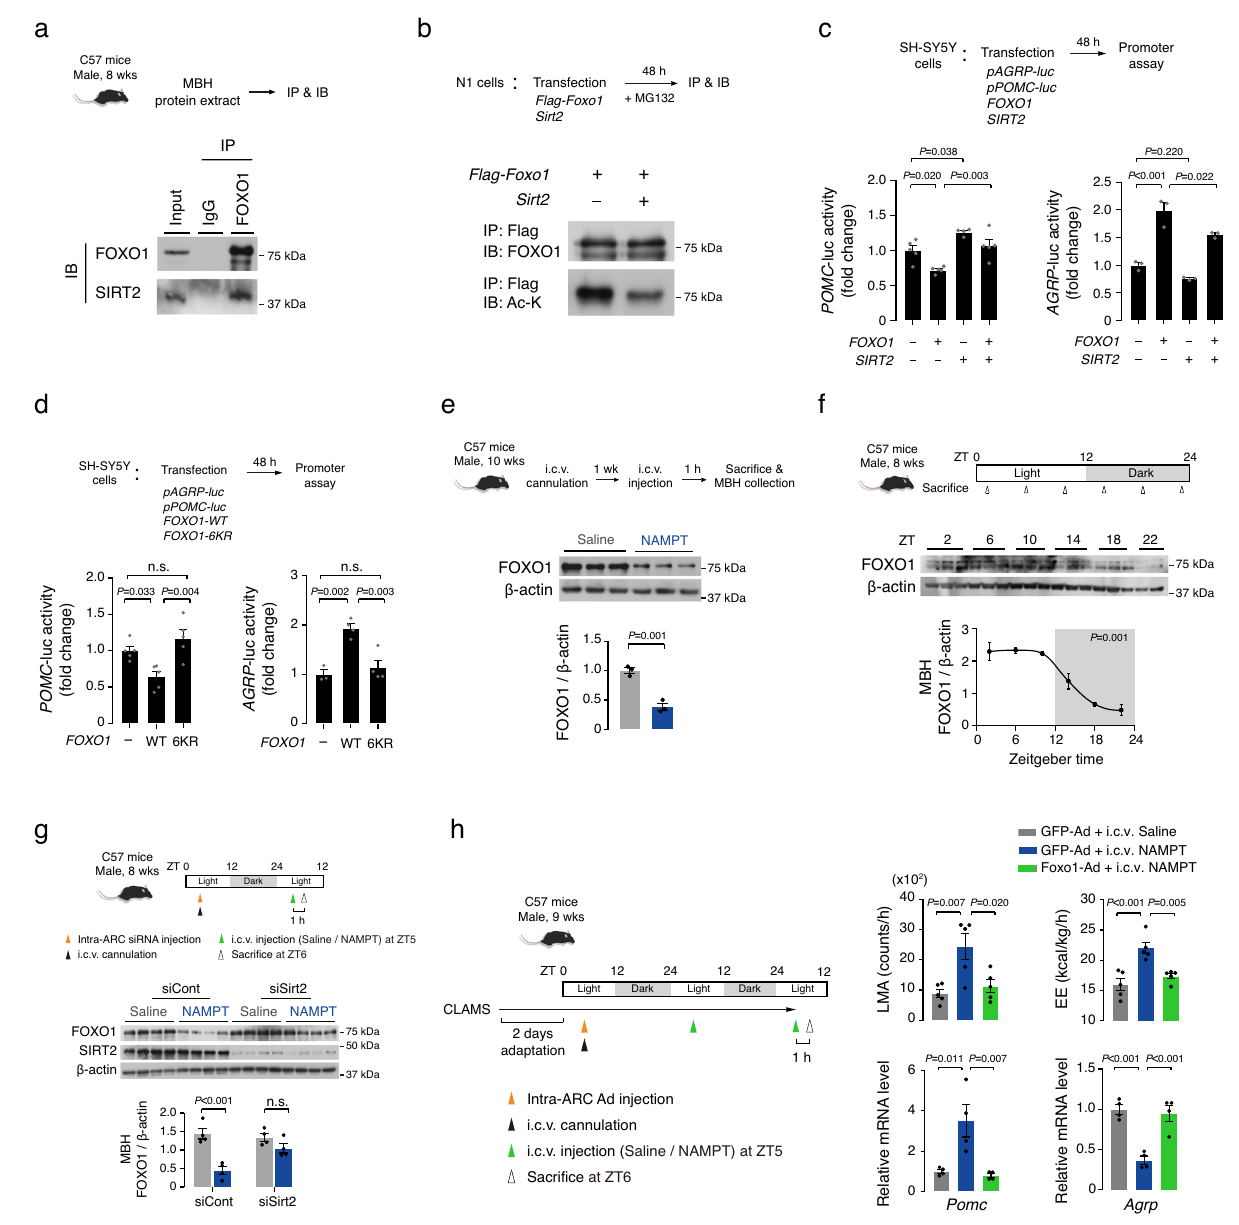
Fig. 6 | eNAMPT inhibits hypothalamic FOXO1 via SIRT2 − mediated deacety- lation. a Molecular interaction of SIRT2 and FOXO1 in C57 mouse hypothalamic protein extracts. IP: immunoprecipitation, IB immunoblotting. b Effect of Sirt2 overexpression on FOXO1 acetylation in hypothalamic N1 cells. Ac-K: acetylated lysine. a , b Two independent replicates were performed. c Antagonizing effect of SIRT2 overexpressionon FOXO1 overexpression-inducedchangesinthe POMC and AGRP promoter activities ( POMC SIRT2 alone, n =4; POMC other groups, n =5; AGRP all groups, n =3 cell wells). One-way ANOVA followed by Fisher ’ s LSD test. d Comparison of the effect of FOXO1 wild type (WT) and deacetylation mutant (6KR) overexpression in the regulatory ability of POMC and AGRP transcription ( POMC , n =5; AGRP Vector, n =3; AGRP WT and 6KR, n =4 cell wells). One-way ANOVA followed by Fisher ’ s LSD test. n.s. not signi fi cant. c , d Three independent